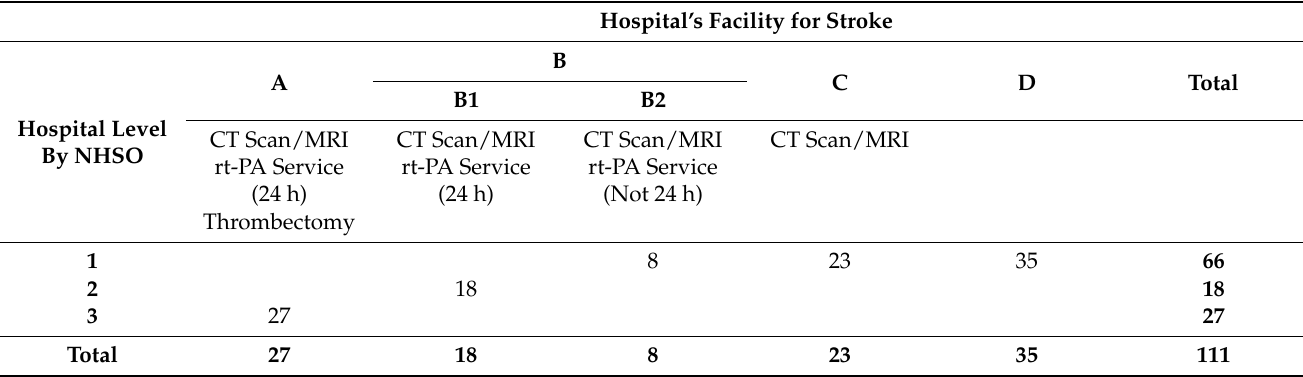
Table 1. Number of hospitals disaggregated by the levels of NHSO Region 13 and the rt-PA facilities available. Hospital’s Facility for Stroke